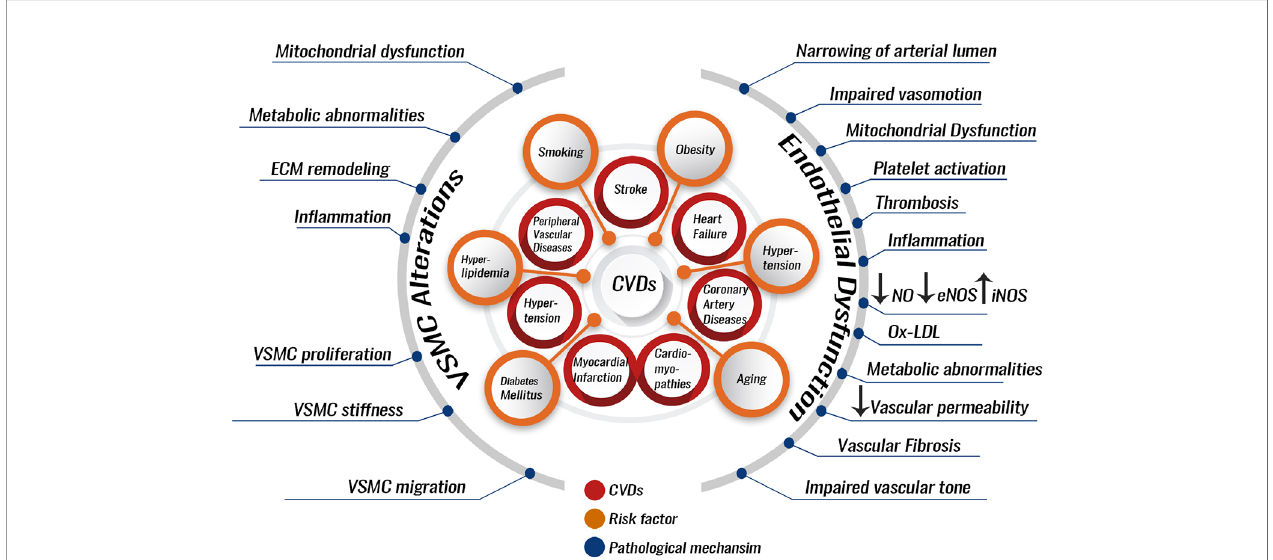
FIGURE 1 | Pathological processes involved in the development and progression of CVDs. Several risk factors can predispose to CVDs. These can include hypertension, smoking, dyslipidemia stemming from an unhealthy diet, or endocrinopathies like diabetes mellitus, hypothyroidism, and aging. The risk factors can lead to pathological alterations most of which can be due to endothelial dysfunction or VSMC alterations. Endothelial dysfunction or VSMC alterations increase the risk of developing atherosclerosis and hypertension. Atherosclerosis and hypertension are themselves CVDs risk factors and enhancers for the development of other CVDs like myocardial infarction, coronary artery diseases, or stroke. VSMC, vascular smooth muscle cell; ECM, extracellular matrix; NO, nitric oxide; eNOS, endothelial nitric oxide synthase; iNOS, inducible nitric oxide synthase; Ox-LDL, oxidized low-density